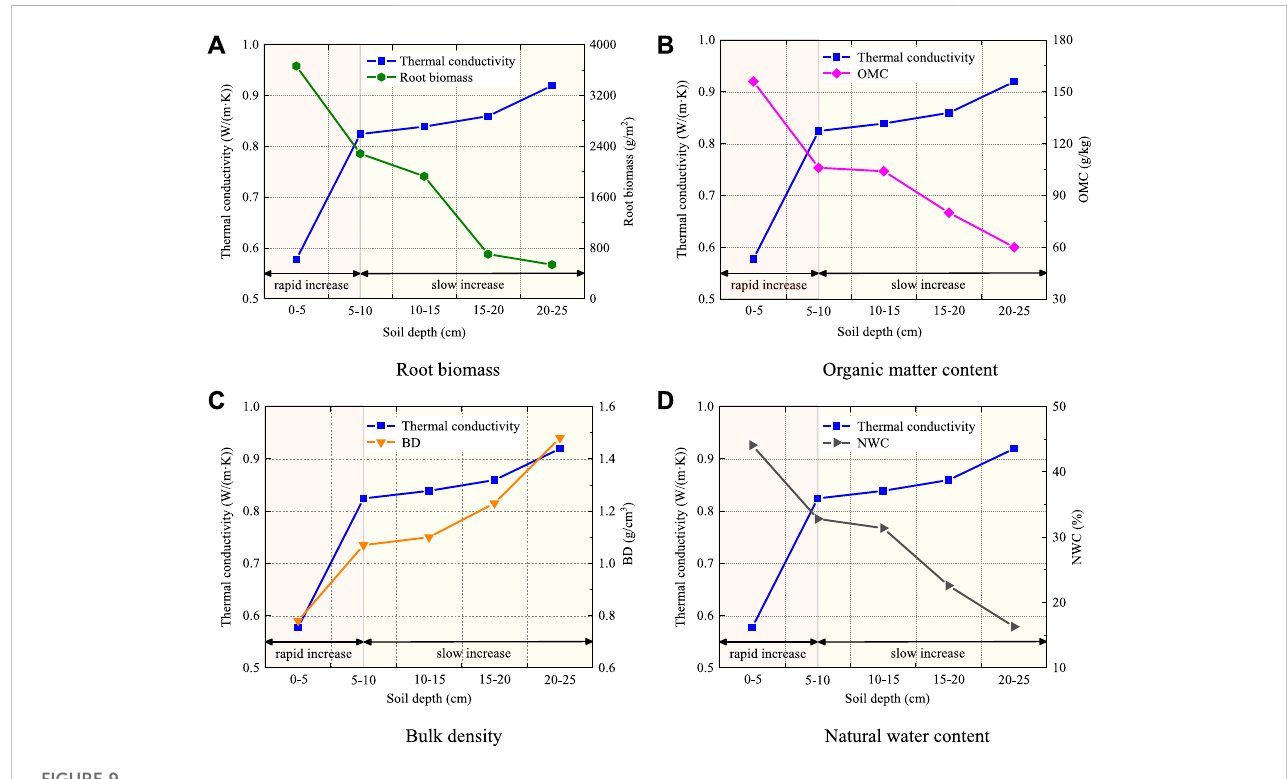
Relationship between thermal conductivity and (A) root biomass, (B) OMC, (C) BD, (D)